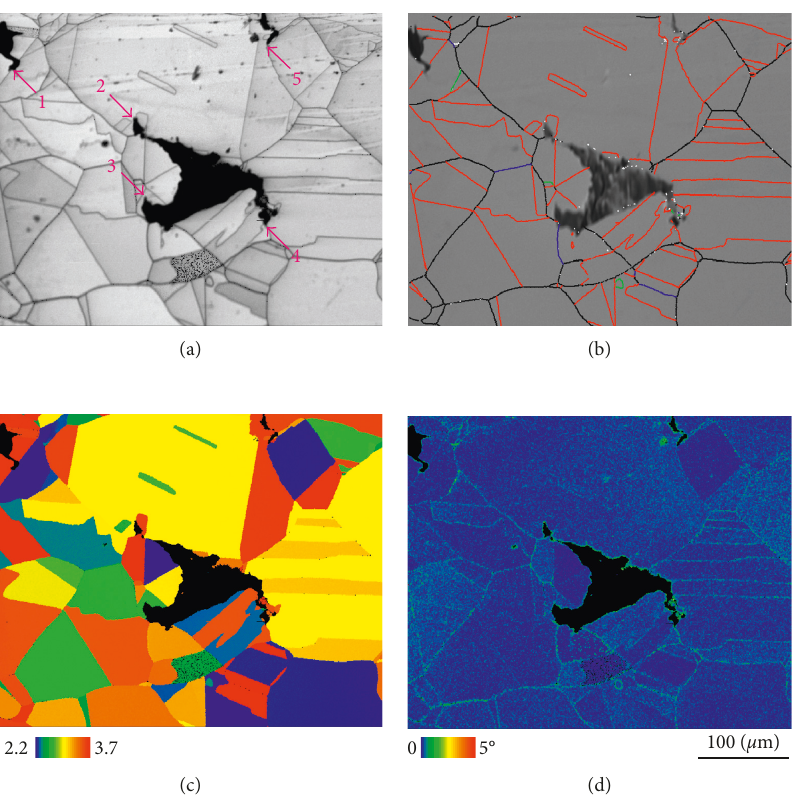
Figure 7: Microstructure of the longitudinal section near the fracture surface of a specimen tensioned at 1050 ° C and 10 − 4 · s − 1 (Region 2). (a) Band contrast image, (b) corresponding SEM map, (c) Taylor factor map, and (d) KAM